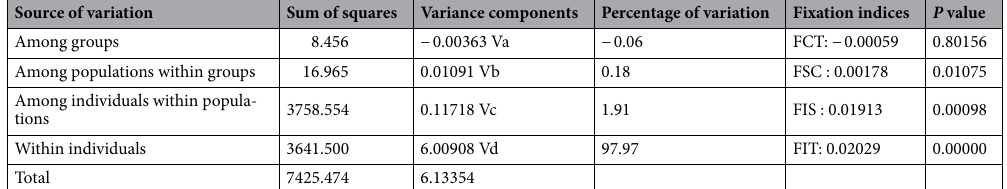
Table 1. Analysis of molecular variance (AMOVA) among the four ethnicities based on linguistic groups.